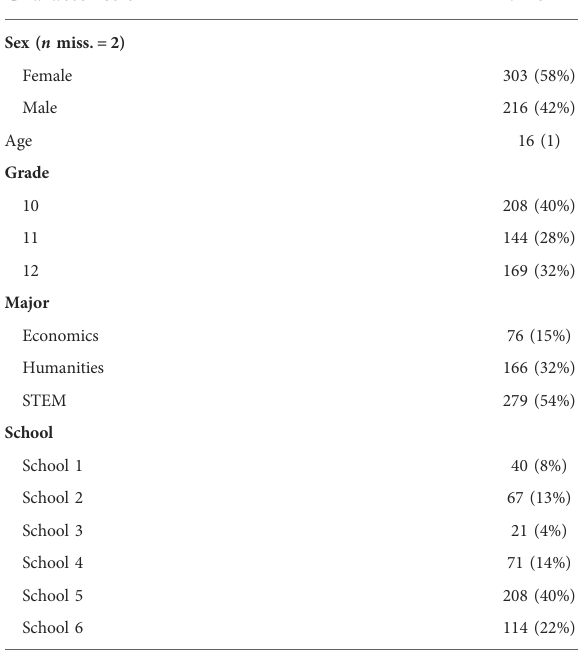
TABLE 1 Student sample